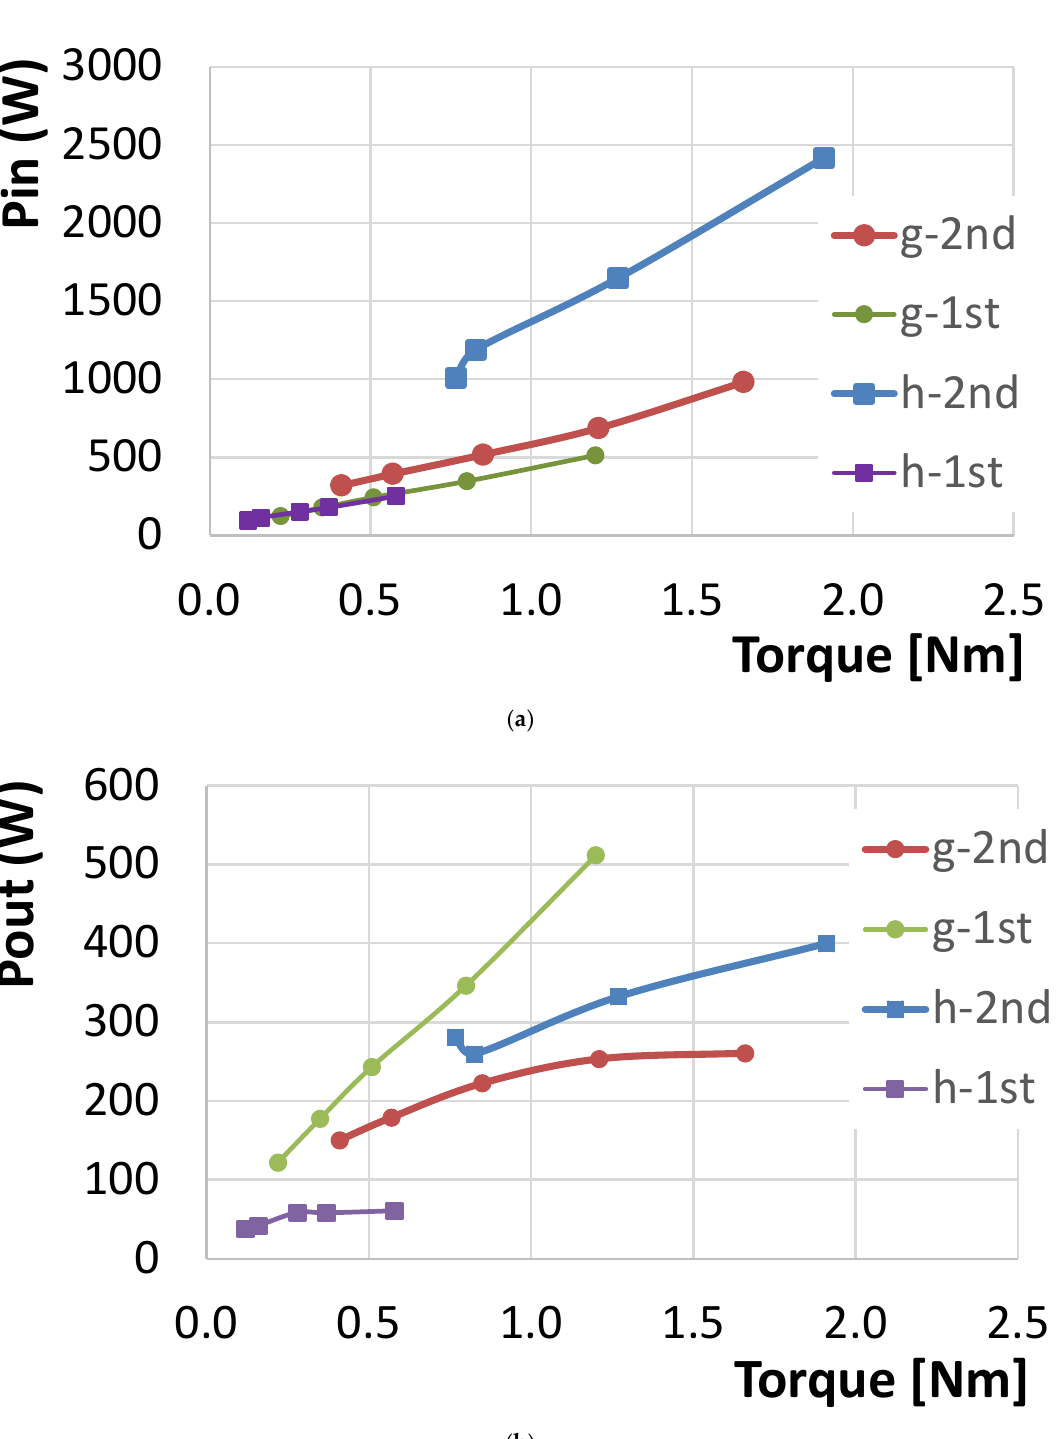
Figure 14. Input (a) and output (b) power vs. torque dependencies of g- and h-winding interconnections, experiments with the Li-Pol battery (1st round), and with the lead-acid battery (2nd round). Since the design had the outrunner construction, the heating aspect needed to be ob- served. In general, the lower the maintained speeds are, the more dominant the observed effect of heating is Figure 15a shows the stator temperature, which reached almost 100 °C